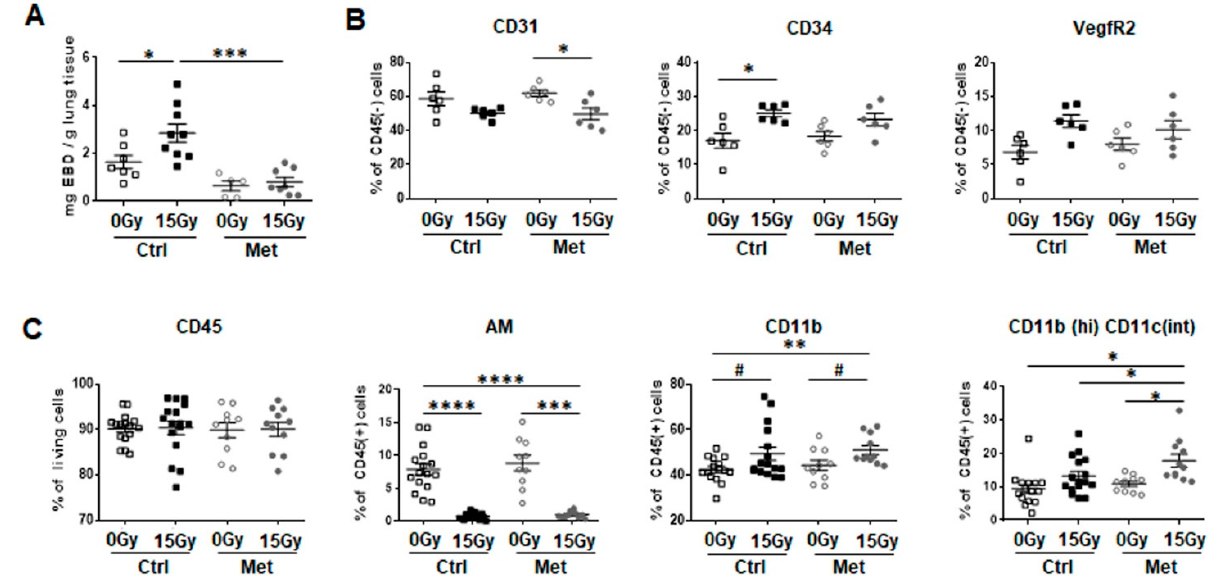
Figure 2. Metformin treatment counteracts radiation-induced vascular dysfunction (acute effect) and recruitment of inflammatory myeloid cells. C57BL/6 mice were left untreated (Ctrl), received five-times a week metformin (Met) treatment, 15Gy WTI, or received WTI in combination five-times a week metformin treatment for first three weeks post WTI. ( A ) Three weeks post irradiation, vascular leakage was determined by intravenously injected Evans Blue dye (EBD) extravasation from the blood stream to the lung interstitium. Extracted EBD concentrations were quantified by absorption measurements and related to lung weight. Symbols represent biological replicates (0Gy Ctrl: n = 7; 15Gy Ctrl: n = 9; 0Gy Met: n = 5, 15Gy Met: n = 8) with indicated mean values ±SEM. p -values indicate * p ≤ 0.05, *** p ≤ 0.001 by one-way ANOVA with post hoc Tukey’s multiple comparison test. ( B ) Endothelial marker expression in crude cell extracts of freshly isolated lung tissue were identified using CD31/PECAM1, CD34 and VEGFR2 expressions (of CD45 negative cells) by flow cytometry. Symbols depict individual biological replicates ( n = 6 for each group) with indicated mean values ±SEM. p -values indicate: * p ≤ 0.05 by one-way ANOVA with post hoc Tukey’s multiple comparison test. ( C ) Leukocytes were identified using CD45 expression and myeloid cells were further characterized using CD11b and CD11c antibodies. Alveolar macrophages (AM) measured as CD11c(high)CD11b(intermediate) cells, CD11b(+)CD11c(-) myeloid cells (monocytes/granulocytes) and CD11b(high)CD11c(intermediate) phagocytic cells are depicted as symbols (individual biological replicates) with mean values ±SEM. p -values indicate: * p ≤ 0.05, ** p ≤ 0.01, *** p ≤ 0.001, **** p ≤ 0.0001 by one-way ANOVA with post hoc Tukey’s multiple comparison test and additionally by unpaired (two-tailed) t -tests depicted as # p ≤ 0.05.